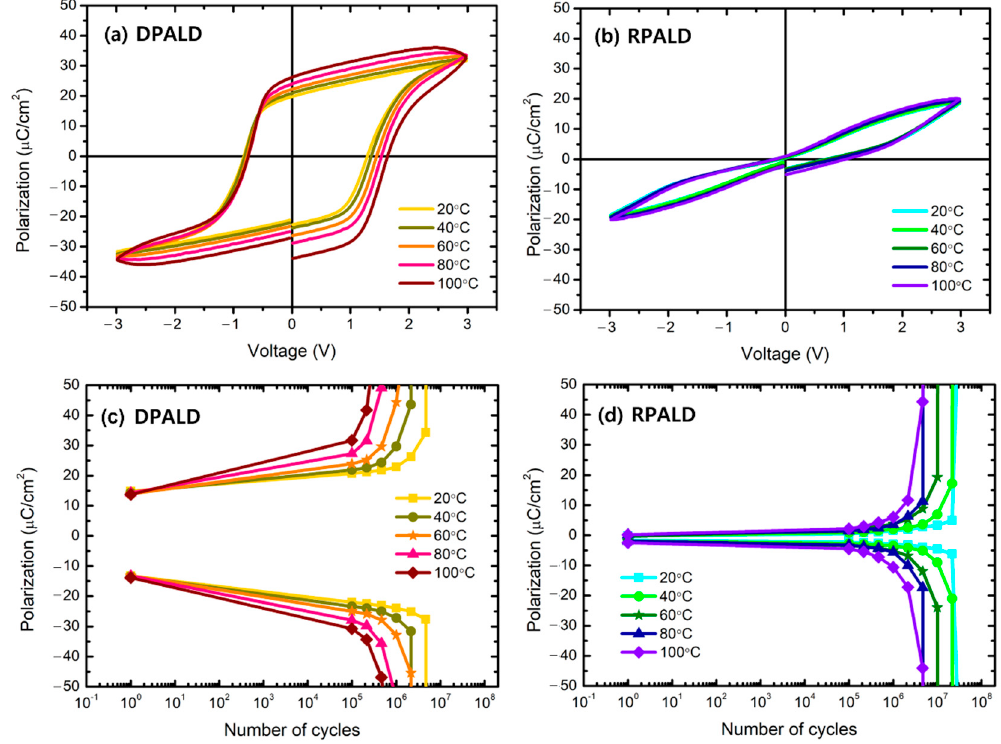
Figure 9. ( a , b ) The P–E hysteresis loop curve after 10 5 cycles and ( c , d ) the fatigue endurance prop- erty of HZO films deposited by DPALD and RPALD methods, according to the measurement tem- perature.